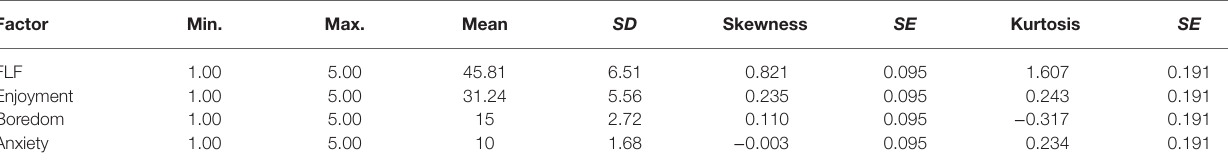
TABLE 6 | Status of Chinese undergraduates’ foreign language flow in blended learning ( N = 655). Factor